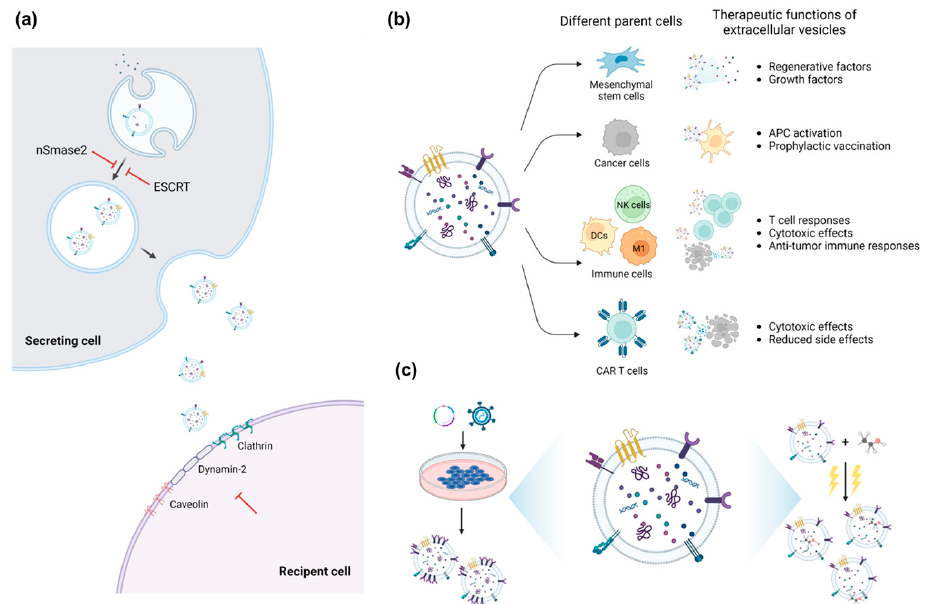
Figure 1. Types and methods of EV-mediated therapeutics. ( a ) Inhibition of sEV release of secreting cells or sEV uptake by recipient cells can be utilized to prevent the progression of diverse diseases. ( b ) sEVs show diverse therapeutic functions depending on the functionality of source cells. ( c ) sEVs can be engineered before and/or after isolation from the cell media. The most well-known meth- ods are the transfection of engineered vectors to embody desired traits or electroporation to load therapeutic proteins into isolated